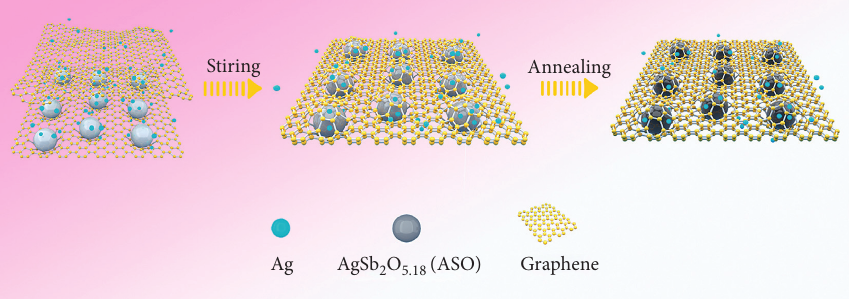
2 O 5.8 and Ag nucleus grow and anchor onto